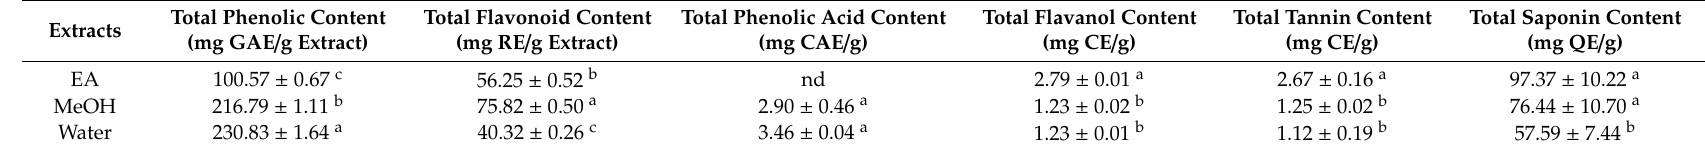
Table 1. Total bioactive components of the tested samples.